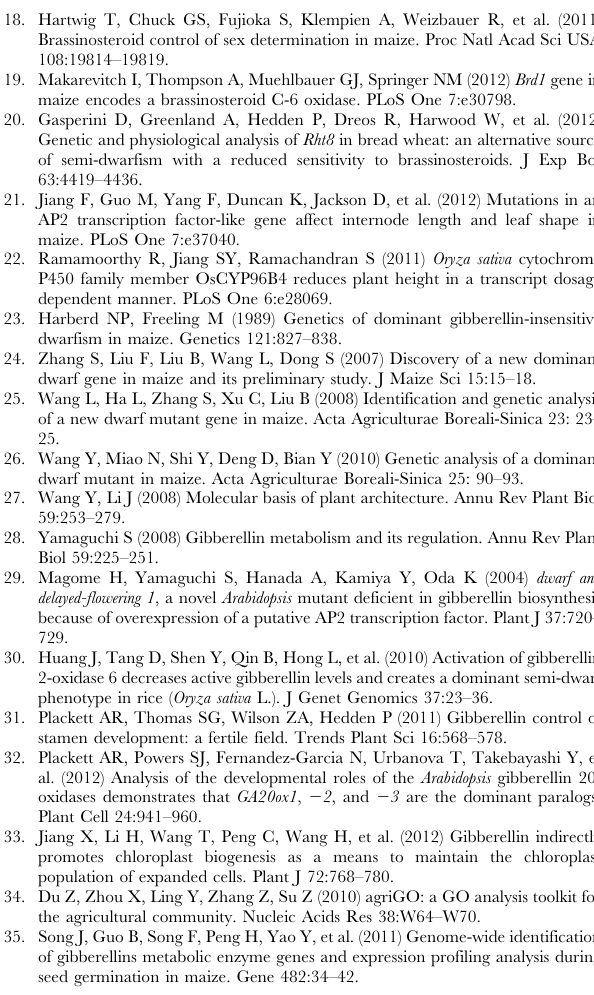
Figure S2 PCR products amplified by primers designed on UTRs of d8 and d9 . M: 1 kb marker; Lanes 1 and 2: amplicons from d8 UTRs primers; Lanes 3 and 4: amplicons from d9 UTRs primers. Figure S3 Response of D11 to GA 3 stimulation. ( A ) Shoot length. ( B ) Coleoptile length. ( C ) The first leaf blade length. ( D ) The first leaf sheath length. ( E ) The second leaf blade length. Data are mean 6 SD ( n = 35). Double asterisks denote significant difference at P # 0.01 level compared with untreated samples by Student’s t test. Figure S4 GO clustering of down-regulated DEGs. Table S1 Segregation in backcross and self-pollination populations from D11 and normal height plants.